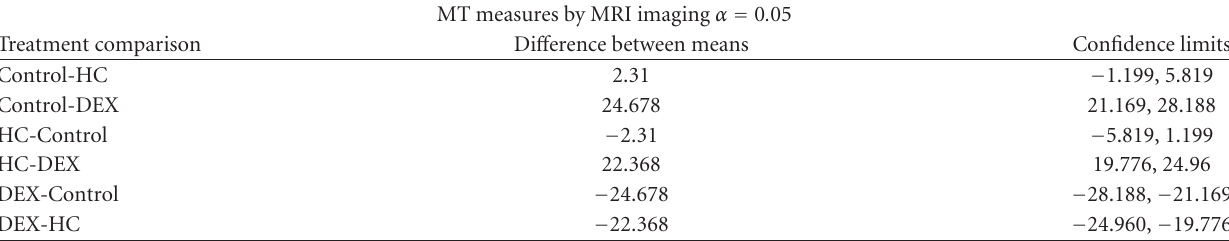
Figure 2: Imaging results compared by treatment group. Under the T2-weighted MRI produced images of MT that appear bright white for both right and left inferior bullae, whereas the dark space represents bone and/or air. The CT images were made for either the right or left bullae, with the bottom quadrant was targeted to match the MRI area that was measured. In the CT imaging, white represents moist MT. In the third column, histology images are presented, where MT demarcation is indicated by the arrow, and the bright pink outside the arrow bounds represents bone. Table 1: Tukey’s followup analysis for MRI measures of MT. MT measures across treatment grouping show that DEX was successful at reducing MT values when compared to both control and HC treated